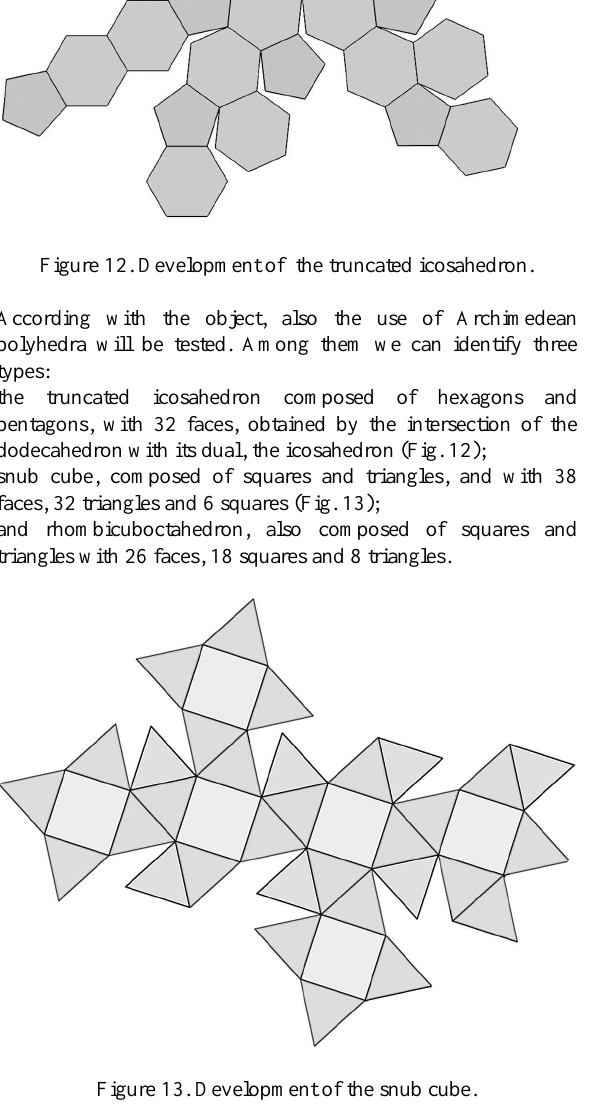
Figure 14. Türkei, Keslik, S. Stephen church, apse, unfolding of the projection on rhombicuboctahedron, M. Carpiceci